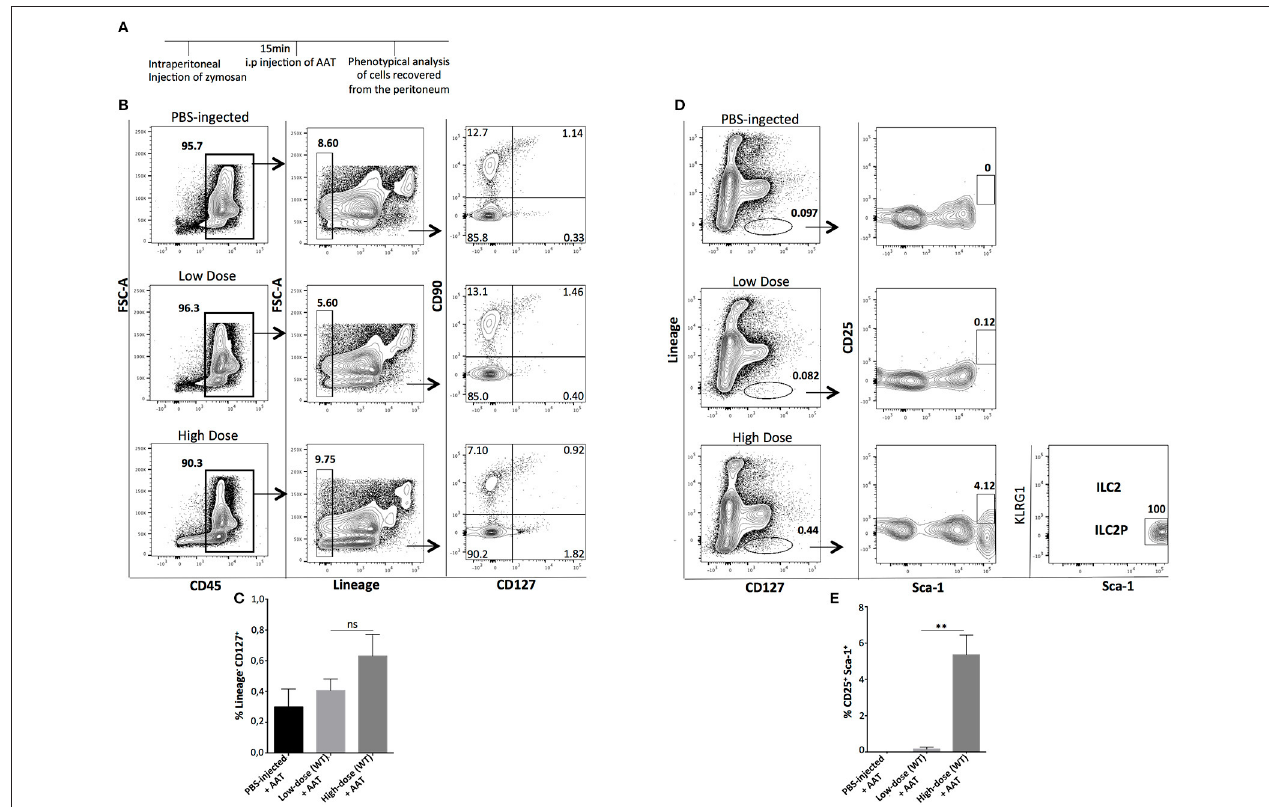
FIGURE 5 | Treatment with Alpha-1-Antitrypsin inhibits the emergence of total ILCs in the peritoneal cavity of zymosan-injected mice. (A) C57BL/6J mice were injected intraperitoneally with low- or high-dose of zymosan and AAT treatment 15min later. Peritoneal fluid from both zymosan-treated and PBS-injected (control) mice was purified and stained for markers of ILCs such as CD45, Lineage, CD127, and CD90. One representative flow cytometry analysis is shown from 4 independent experiments ( n = 4). (B) Cells were stained for Lineage, CD127, CD25, Sca-1, and KLRG-1 in order to identify bone marrow-derived ILC2 and ILC2P cells ( n = 4). (C) Statistical analysis of the frequency of Lineage − CD127 + CD90 + cells ( n = 4). (D) Flow cytometry gating strategy for ILC2 and their progenitor cells (ILC2P) in both mice injected with low- and high-dose of zymosan after treatment with AAT ( n = 4). (E) Statistical analysis for the frequency of Sca-1 + CD25 + cells within CD45 + Lineage − cells ( n = 4). ** p <